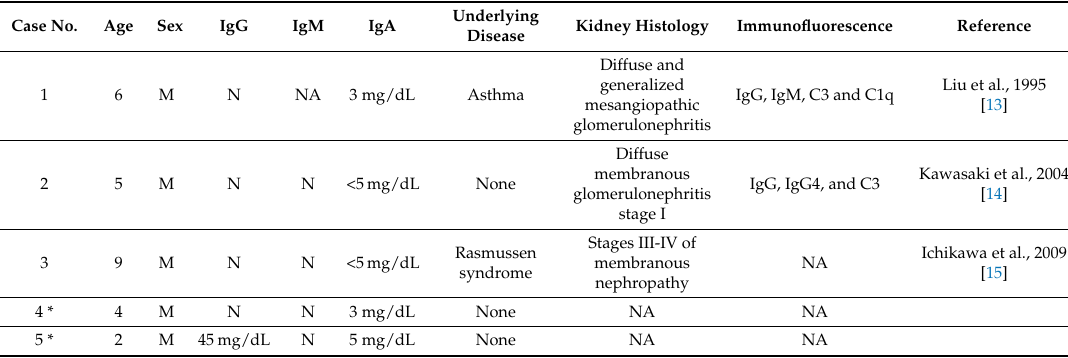
Table 1. Renal pathology in children with IgA